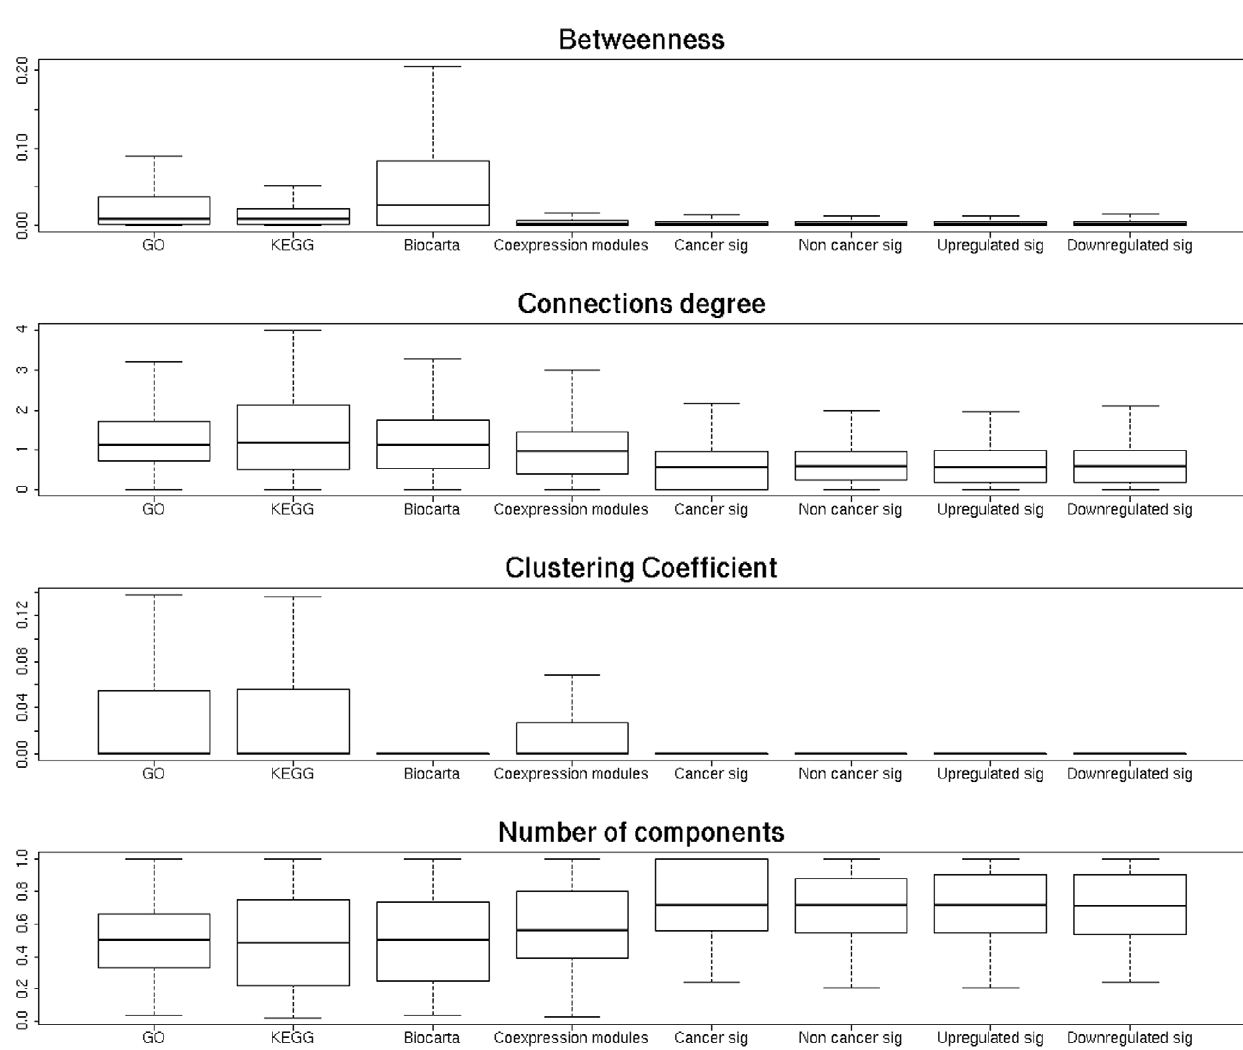
Figure 2. Boxplots representing the distribution of the different network parameters in the different gene module definitions.